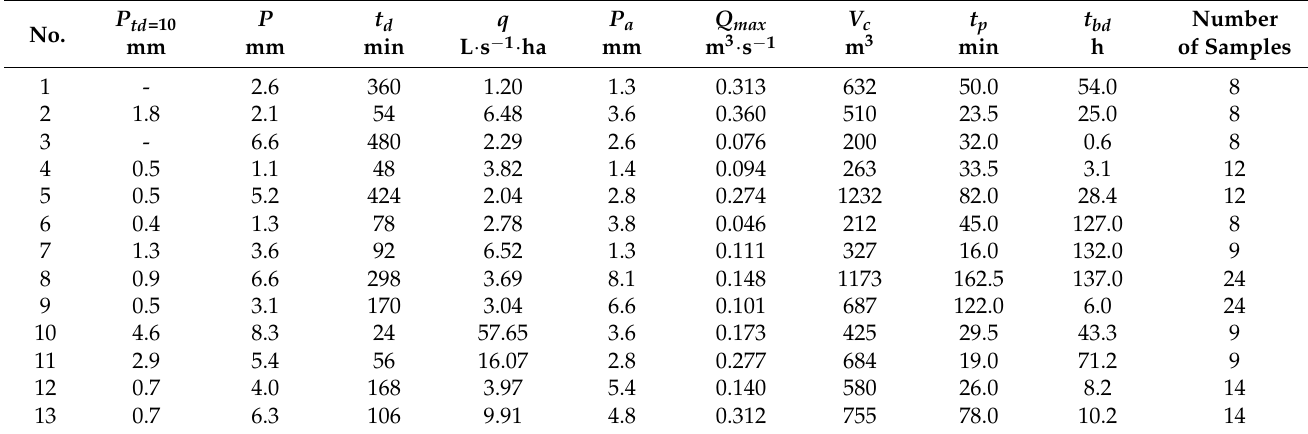
Table 1. Parameters of the observed high water stages and